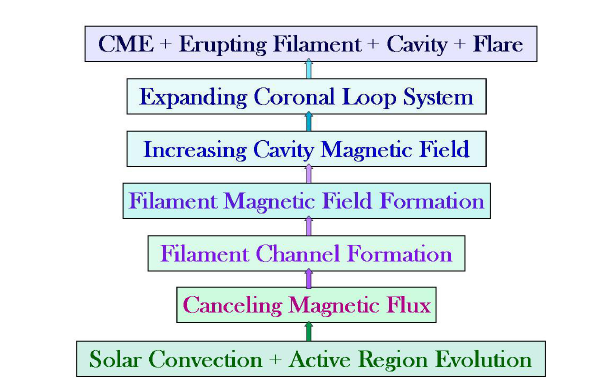
Fig. 3. Diagram of observed and inferred stages in the build-up to Figure 3. Diagram of observed and inferred stages in the build-up to eruptive events eruptive events beginning with the lowest block and proceeding in beginning with the lowest block and proceeding in approximate sequential order to the approximate sequential order to the eruptive event represented at the eruptive event represented at the top. The process can continue through a series of eruptive top. The process can continue through a series of eruptive events events until the canceling flux ceases or falls below an assumed critical level. until the canceling flux ceases or falls below an assumed critical